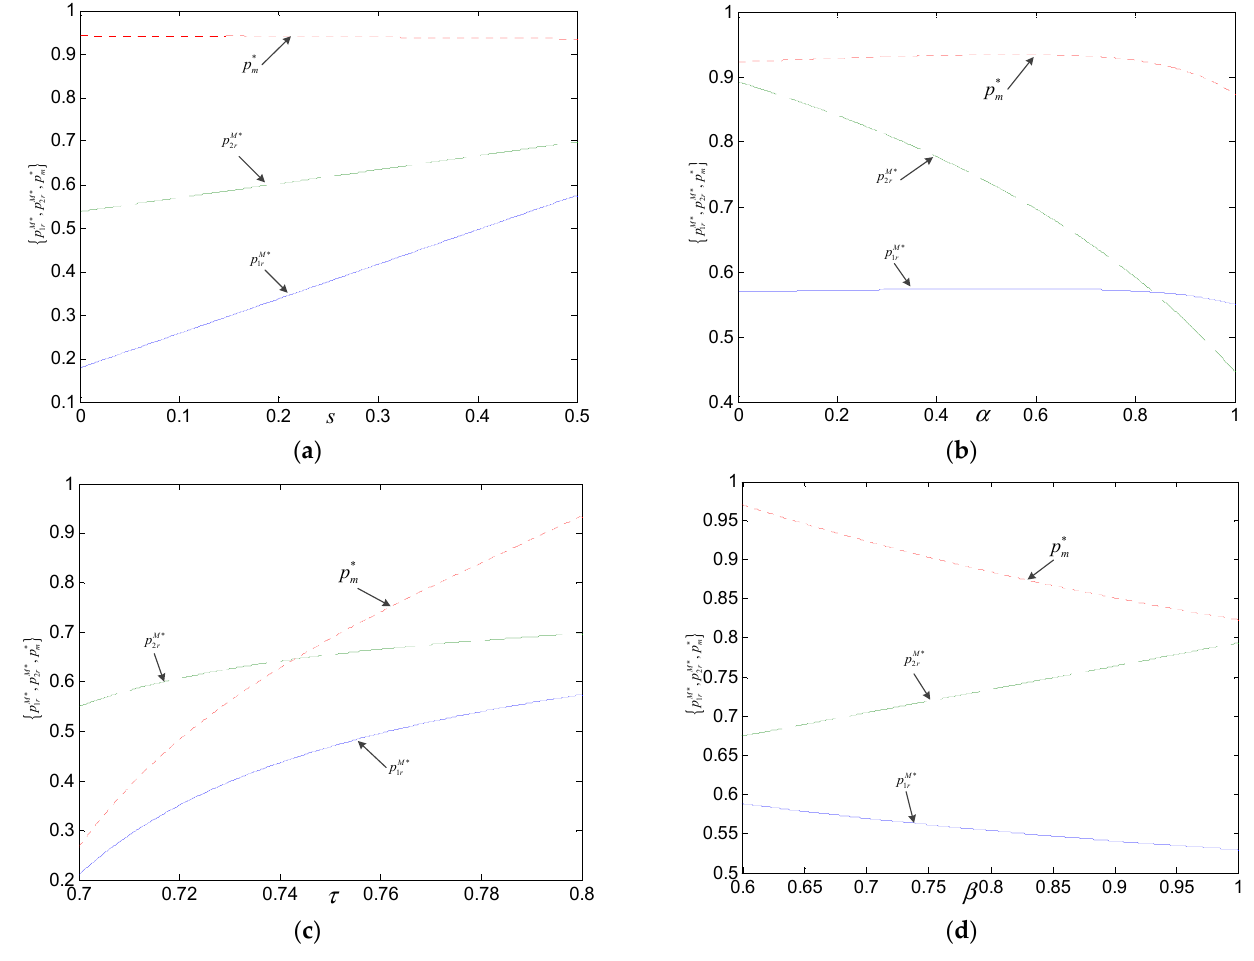
M M p , * p , * p }. ( a ) The , p M ∗ , p ∗ m }. ( a ) The 1 2 m r r 2 r 1 r , p M ∗ , p ∗ m }; ( c ) The impact of τ on { p M ∗ , 2 r 1 r 1 r